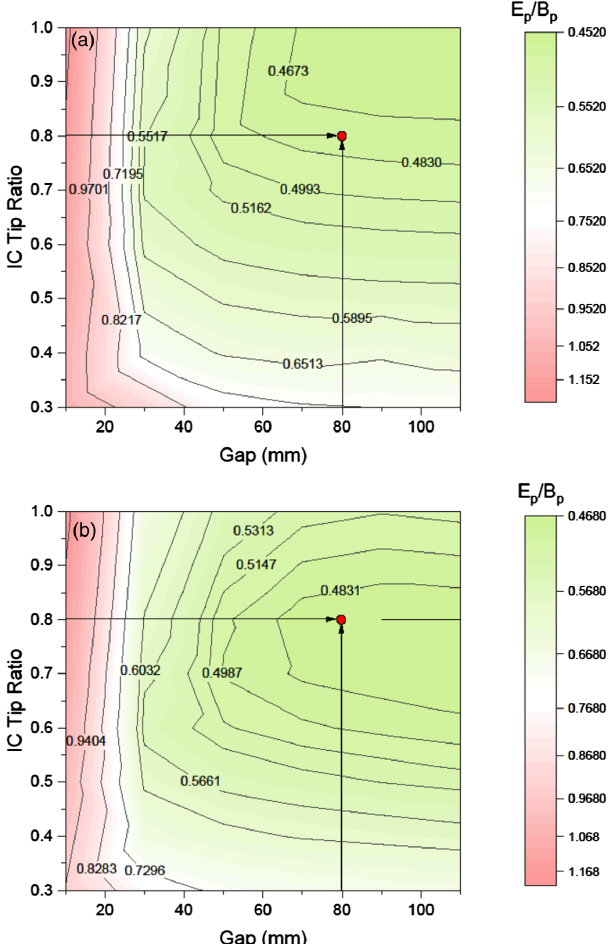
FIG. 4. Heat maps of E p =B p as a function of the capacitive gap and IC tip ratio to determine a design with a similar E p =B p in both the first (a) and second (b) TEM modes. The marker indicates the chosen design with E p =B p ≈ 0 . 47 ð MV = m Þ =